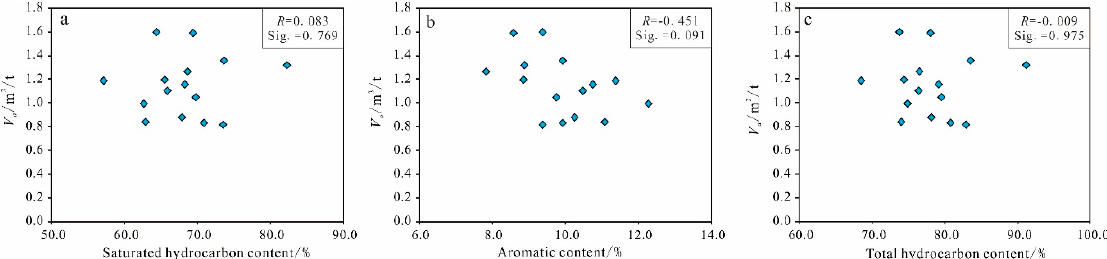
Figure 9. Correlations between V a and three components of chloroform bitumen “A”. ( a ) Correlations between V a and saturated hydrocarbon content; ( b ) correlations between V a and aromatic content; ( c ) correlations between V a and the total hydrocarbon content.